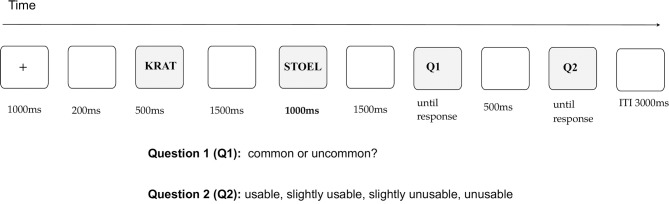
The sequence of stimuli together with exposure times are displayed. Participants answered two questions: whether a given use appeared common or uncommon to them (question 1), and how usable they thought a given use was (question 2).